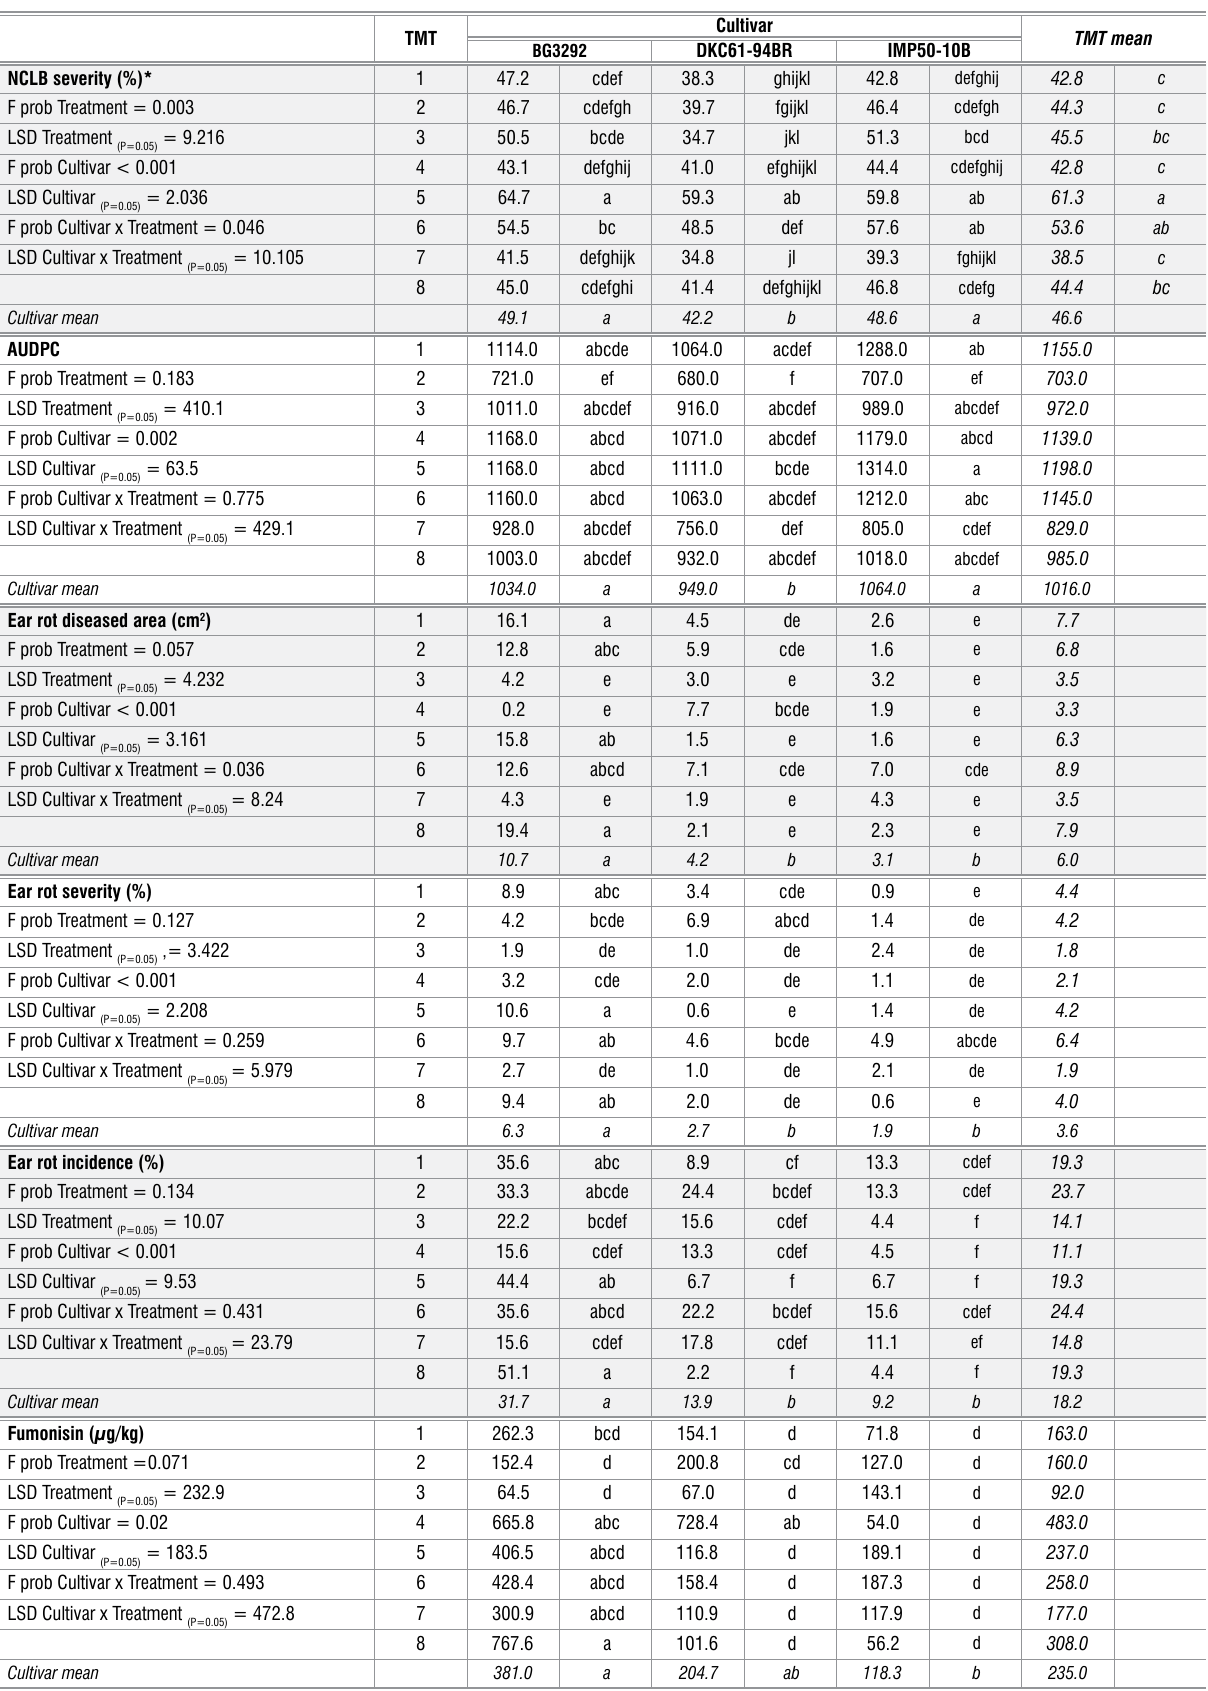
Table 4: Northern corn leaf blight (NCLB) and ear rot related data generated for the first planting trial during 2017/2018